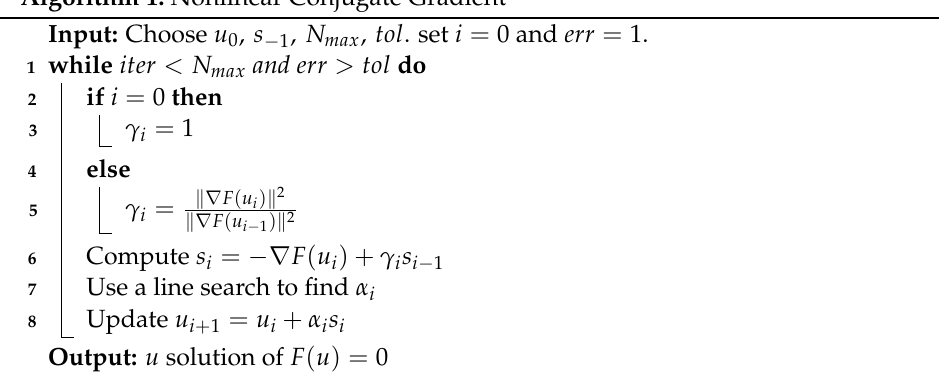
Algorithm 1: Nonlinear Conjugate